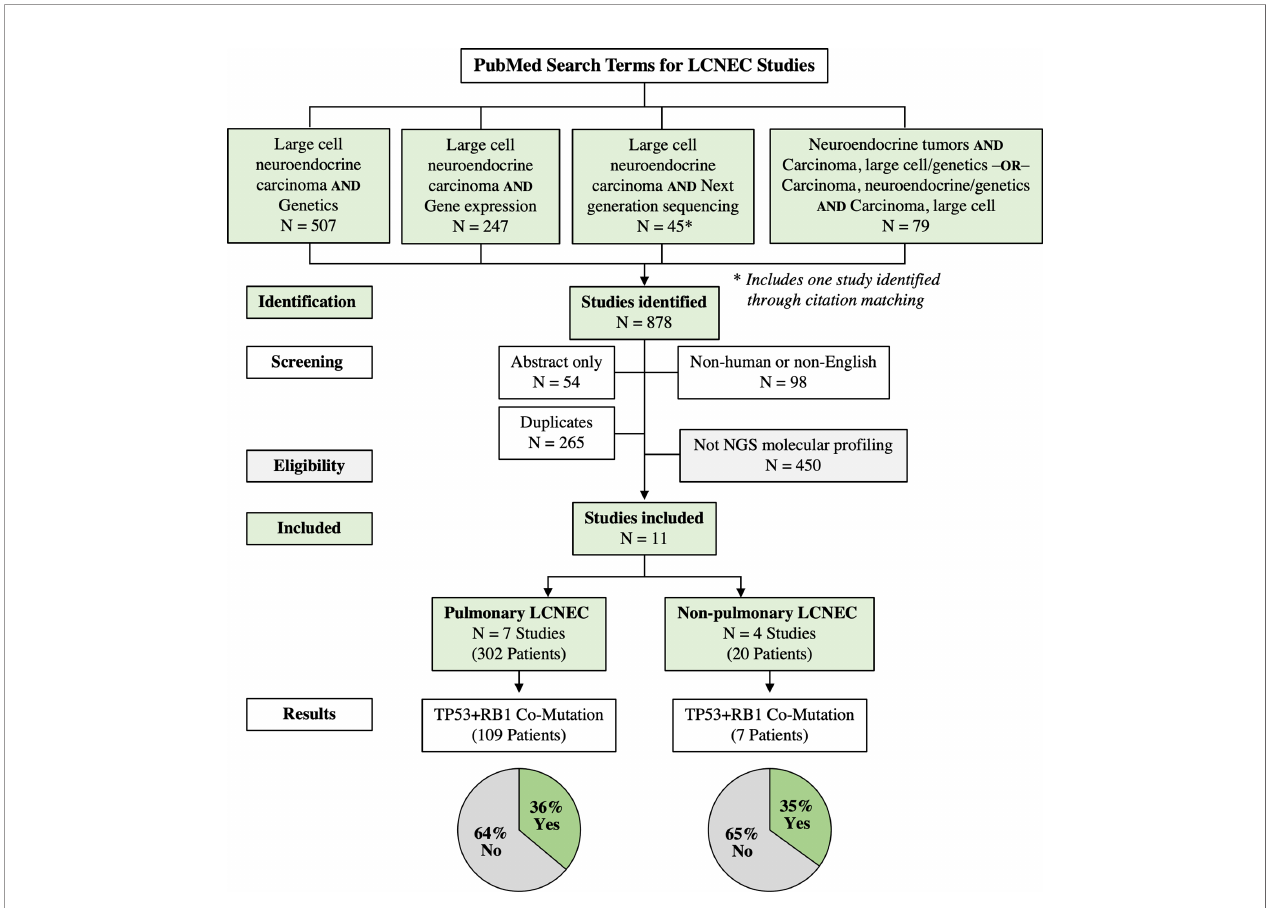
FIGURE 1 | Flow Diagram of Search Results for